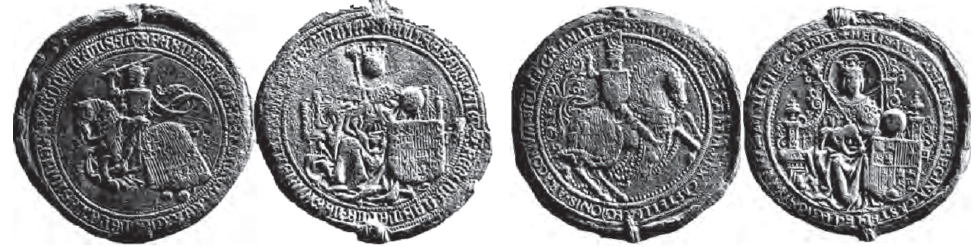
Figure 2. Lead Bulls of the Catholic Monarchs. Undated. Published by [29], nums. 112, 131. On the obverse, surrounded by + FERDINANDVS: DEI: GRACIA: REX: CASTELE: LEGIONIS : ARAGONVM : ET SEC, we can see the king mounted on his horse, which is facing either right or left and appears less light of foot than its predecessors because its